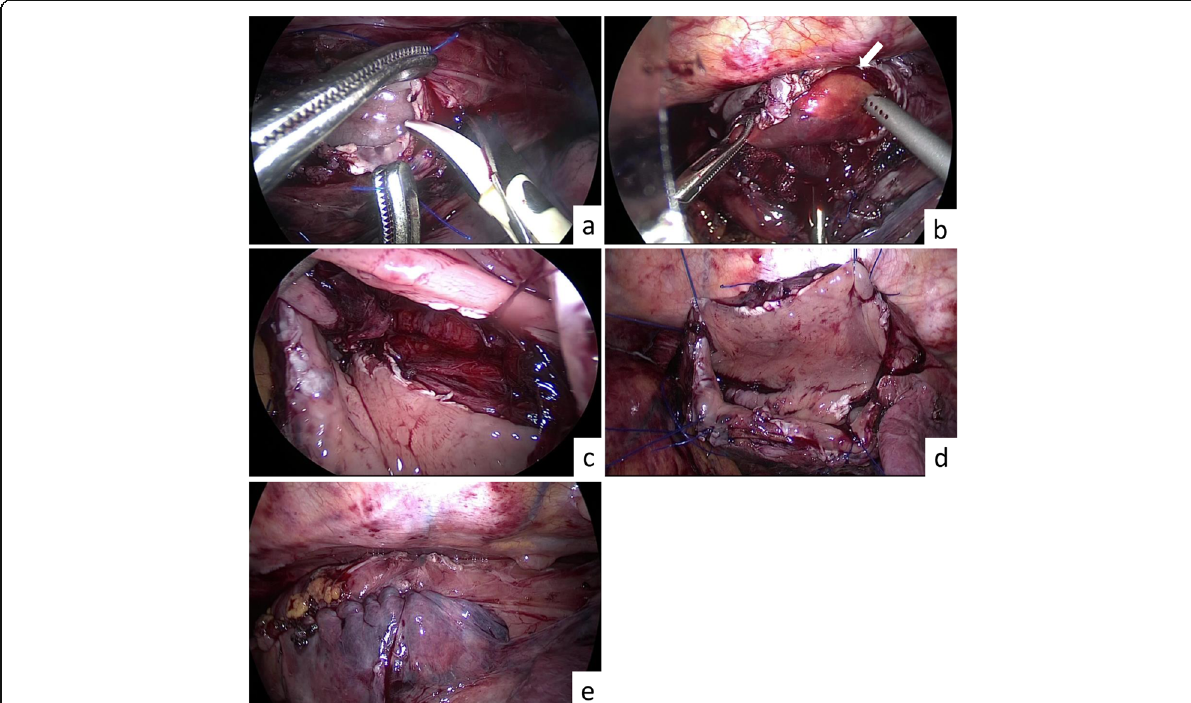
Fig. 2 Thoracoscopic enucleation of a giant esophageal lipoma. a A longitudinal incision of the right esophageal wall was performed. b A longitudinal incision of the mucosa of the left esophageal wall was performed, and a lipoma (arrow) started to rise. c After enucleation. Muscle layer was not injured. d Four retraction sutures were placed on esophageal wall and held by an assistant. e After suturing the mucosa and esophageal